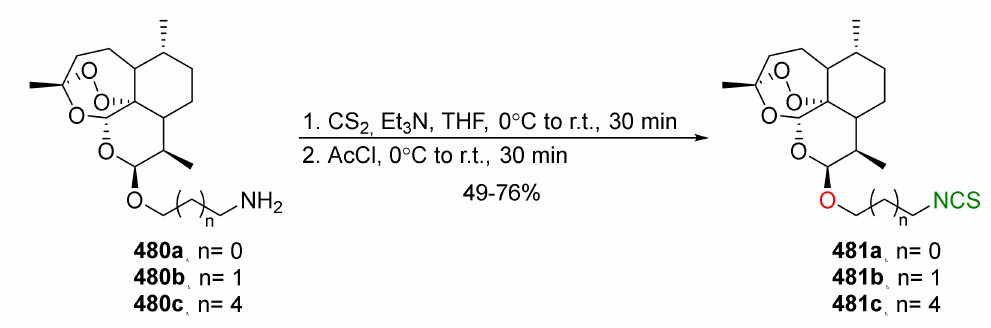
Figure 56. Synthesis of artemisinin–isothiocyanate derivatives 481a – c